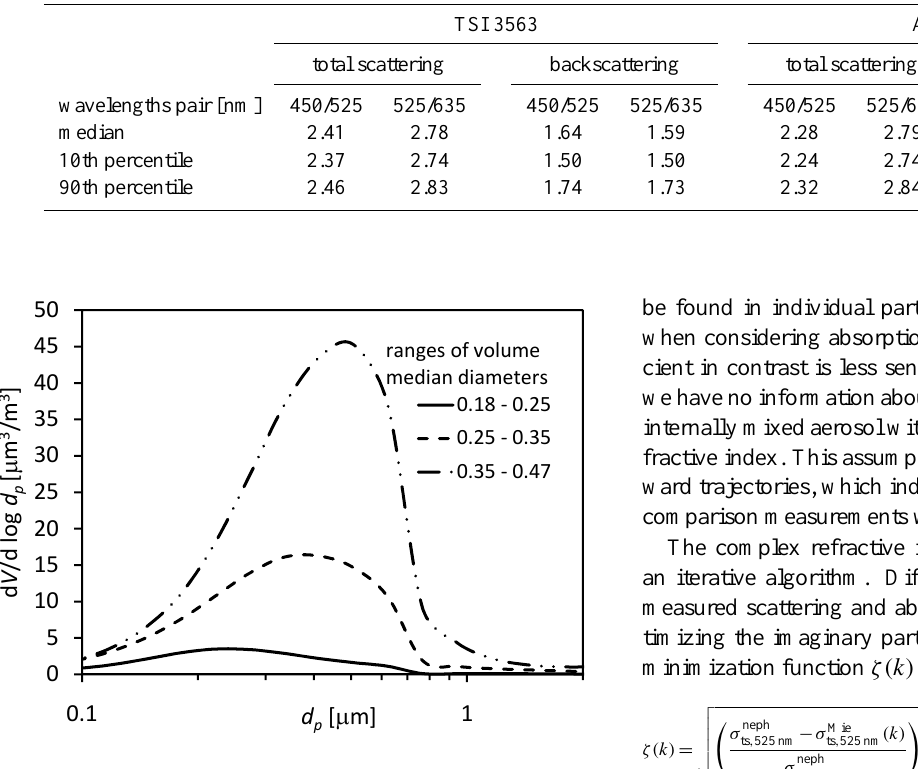
Fig. 7. Average particle volume size distributions for ambient air classified for three ranges of volume median